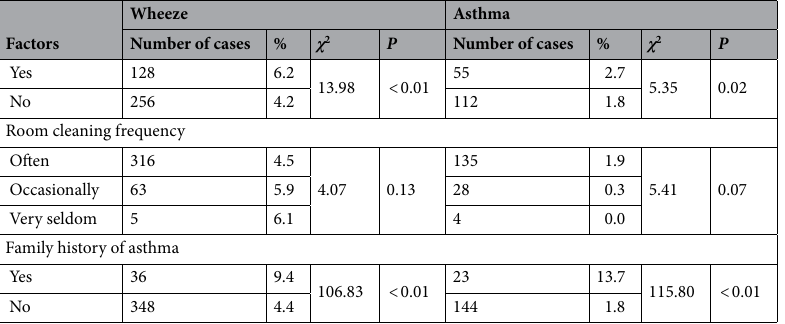
Table 2. Univariate analysis of wheeze and asthma with indoor environmental variables ( n = 8153).